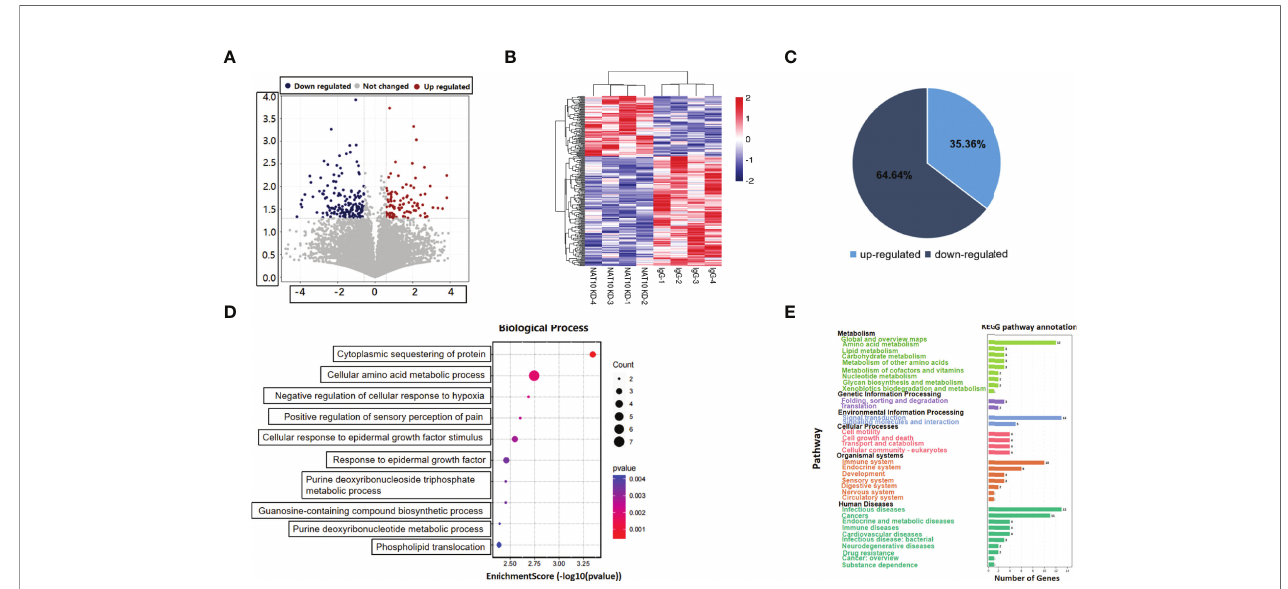
FIGURE 1 | Expression pro fi ling of NAT10-depleted mouse oocytes. (A) Volcano map showed the gene expression with NAT10 KD. Blue dots represented downregulation, and red dots represented upregulation. (B) The heatmap showed clusters of differential expression of genes. (C) Pie chart presented the proportion of up/downregulated genes in 280 DEGs. (D) Cellular amino acid metabolic process and cytoplasmic sequestering of protein were main biological process of 280 DEGs. (E) A total of 280 DEGs were enriched in metabolism and signal transduction according to KEGG enrichment